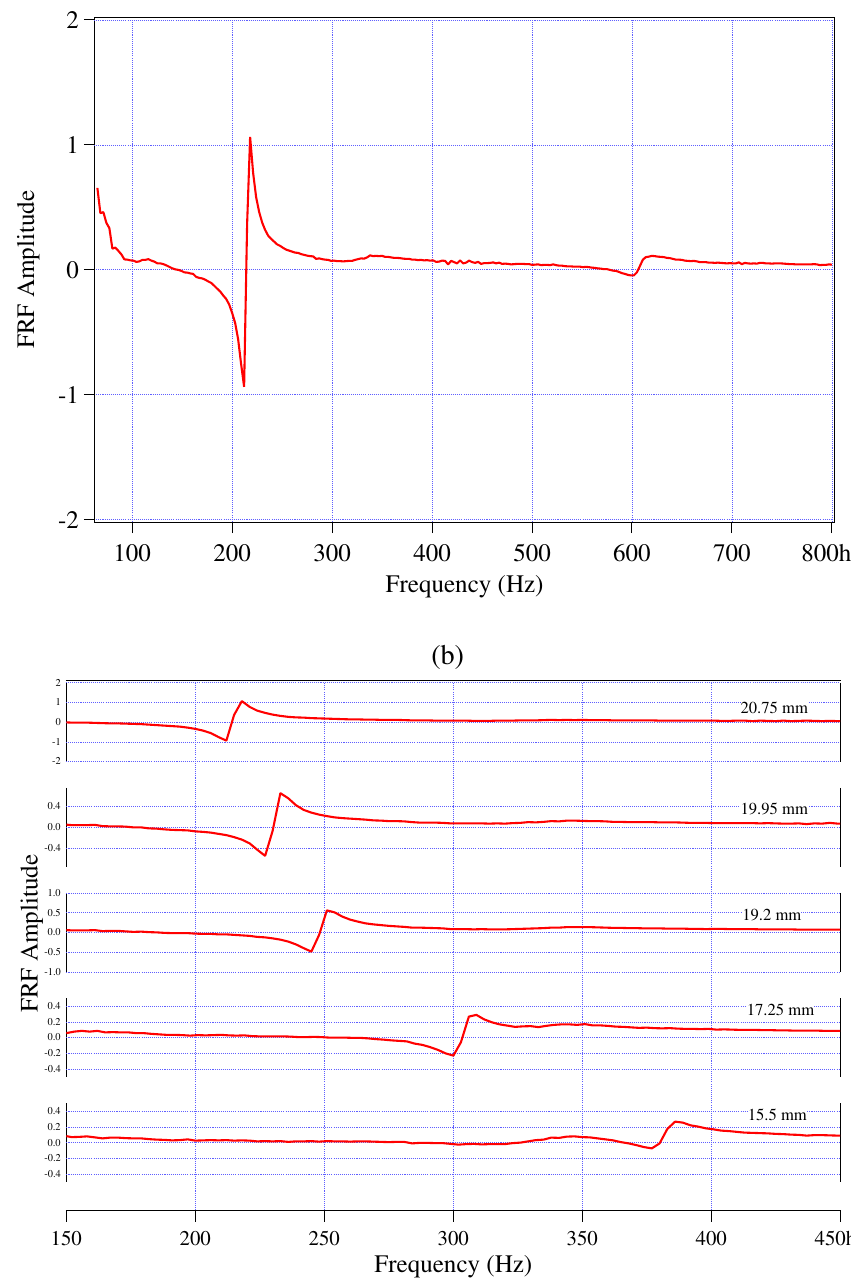
Figure 2 . (a) A typical raw data FRF of a PVF 2 cantilever device in the frequency range 65 - 800 Hz. (b) FRF’s showing the shift in resonance frequencies with cantilever